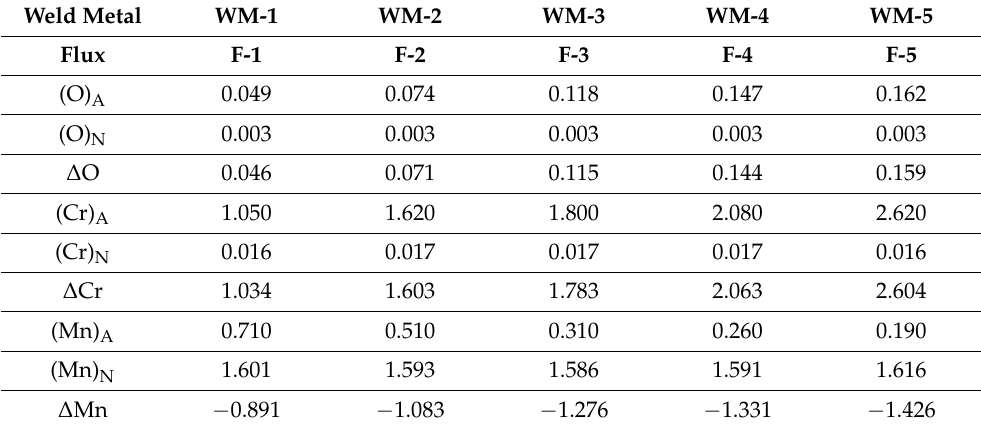
Table 5. Nominal compositions, measured WM compositions, and quantified ∆ values (wt.%). Weld Metal WM-1 WM-2 WM-3 WM-4 WM-5 Flux F-1 F-2 F-3 F-4 F-5 (O) A 0.049 0.074 0.118 0.147 0.162 (O) N 0.003 0.003 0.003 0.003 0.003 ∆ O